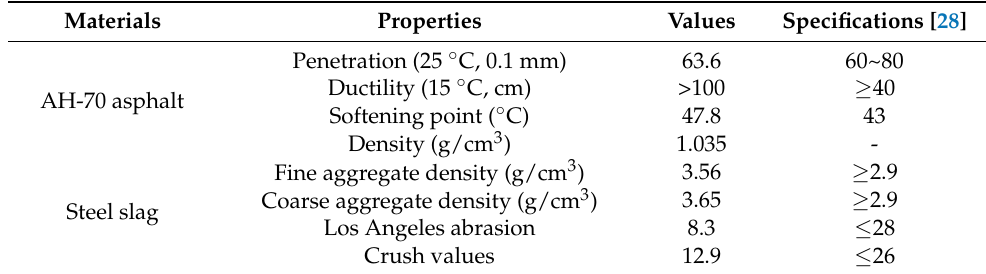
Table 1. Properties of AH-70 asphalt and steel slag.